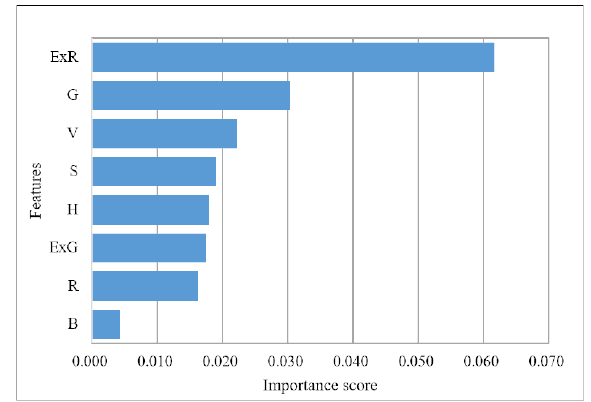
Figure 5. Importance derived by permuting each feature and computing change in accuracy.